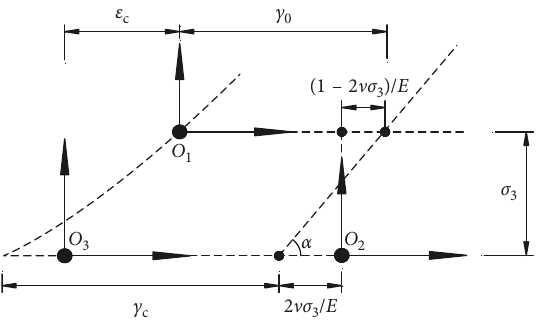
Figure 5: Positional relationships between 3 coordinate systems.